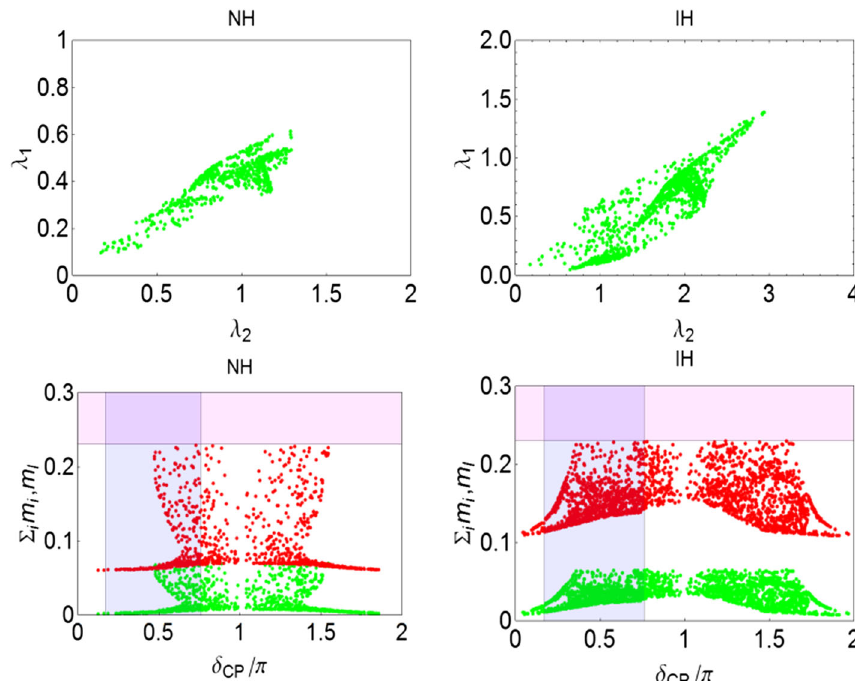
Fig. 3 Correlation plots between λ 1 and λ 2 for the normal hierarchy (top left panel), for the inverted hierarchy (top right panel) and between (cid:4) i m i (red points), m l (green points) and δ CP in the bottom left (right) panel for the normal (inverted) hierarchy. The vertical and horizontal bands represent the values of δ CP beyond its 3 σ range and (cid:4) i m i > 0 . 23 eV, the upper bound on the sum of active neutrino masses given by the Planck data,